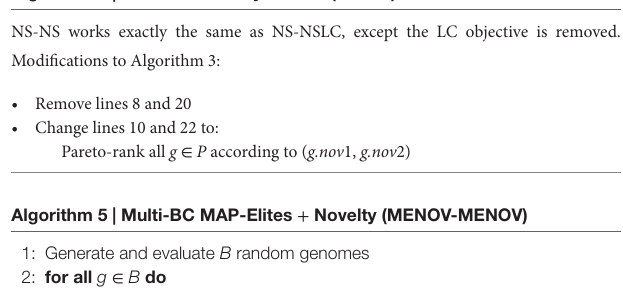
algorithm 4 | Multi-Bc novelty search (ns-ns)